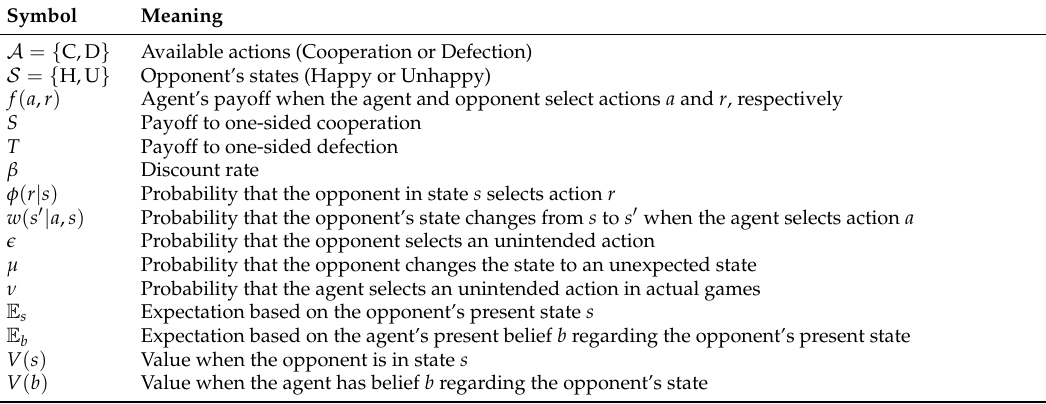
Table 4. Meaning of